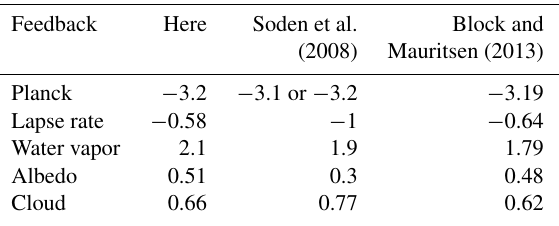
Table 2. Comparison of TOA radiative feedbacks. TOA radiative feedbacks (Wm − 2 K − 1 ) averaged over 40 CESM large-ensemble simulations diagnosed with CAM5 radiative kernels, compared against those from CMIP3 model simulations diagnosed with three different kernels as reported by Soden et al. (2008), and MPI-ESM- LR control state kernels and years 21–150 of abrupt carbon dioxide quadrupling simulations from the same model (Block and Maurit- sen, 2013). Feedback Here Soden et al. Block and (2008)